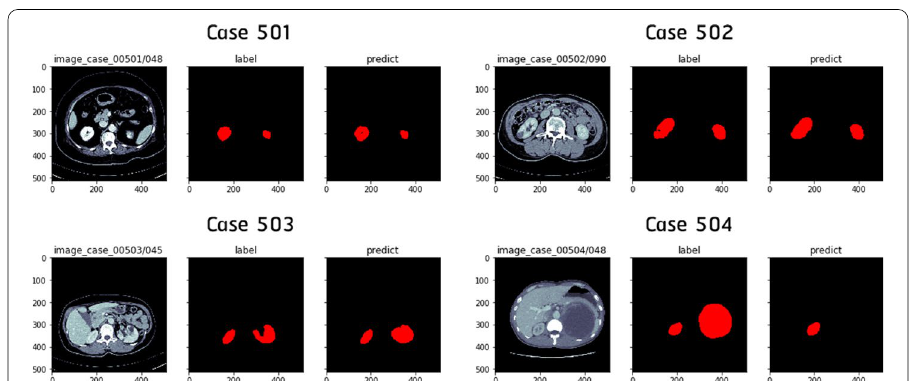
Fig. 3 Kidney segmentation results regarding four Thai patients using 2.5D ResUNet (slice stack of 5) trained in Google Colab Pro